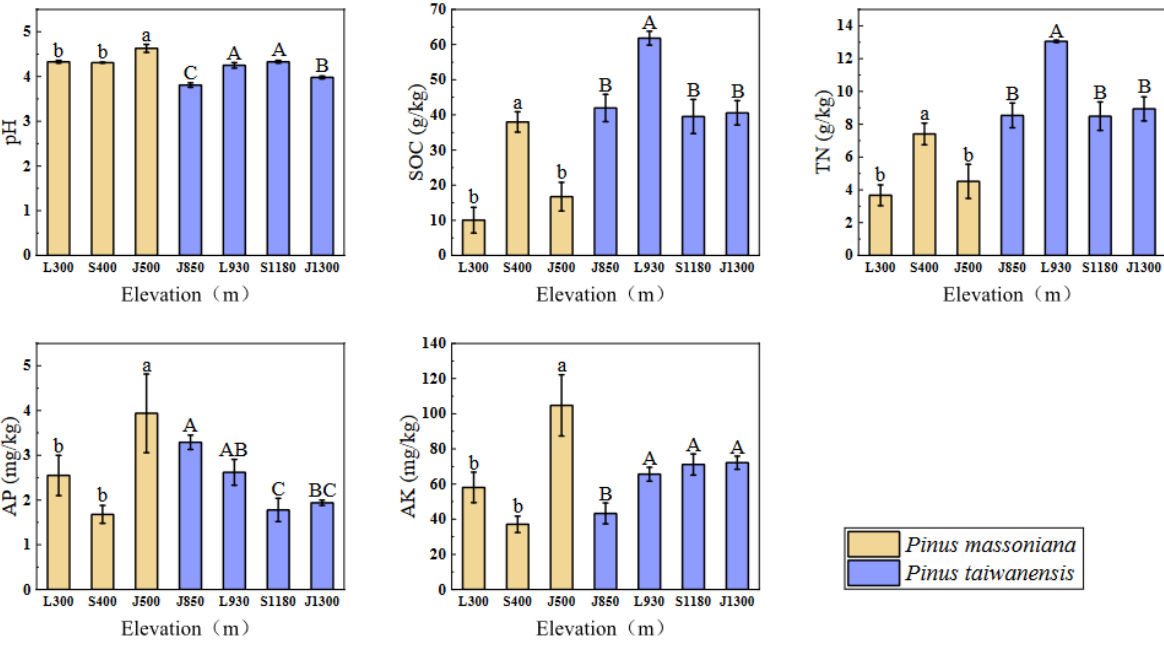
Figure A2. The soil characteristics in Pinus taiwanensi and Pinus massoniana forests soils with the elevations. Yellow for Pinus massoniana and blue for Pinus taiwanensi .